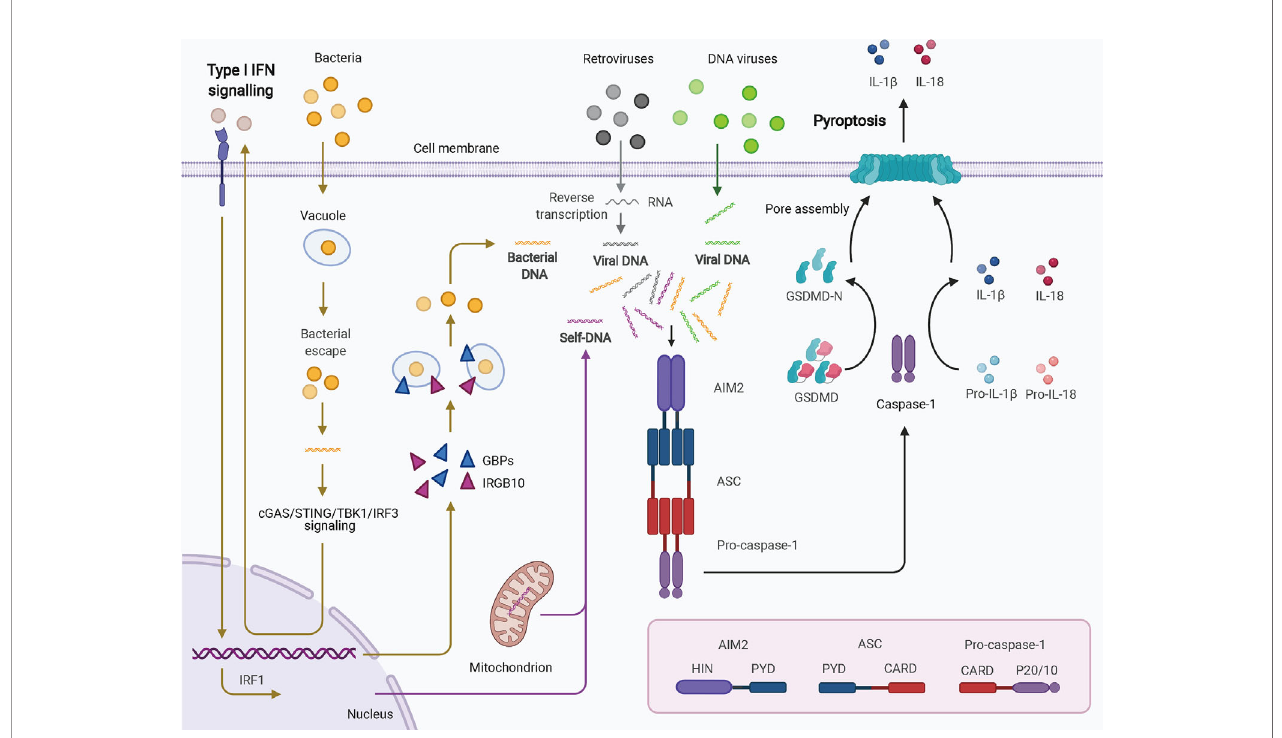
FIGURE 2 | Schematic of AIM2 in fl ammasome activation. Cytosolic DNA from virus and self-origin directly causes “ canonical ” activation of the AIM2 in fl ammasome (arrows in grey for retroviruses, green for DNA viruses, and purple for self-DNA). However, bacteria-induced “ noncanonical ” activation of the AIM2 in fl ammasome is dependent on type I IFN signaling (yellow arrows). In this scenario, small amounts of DNA may be released from intracellular bacteria that escape from vacuoles; this DNA can be detected by cGAS. Through cGAS/STING/TBK1/IRF3 signaling, type I IFN drives IRF1 expression in an autocrine manner. GBPs and IRGB10 are then produced and disrupt the bacterial membrane and vacuoles containing bacteria, leading to exposure of a mass of DNA. DNA is then recognized by the AIM2 in fl ammasome. AIM2 oligomerizes and interacts with pro-caspase-1 with the help of ASC. The activated caspase-1 processes pro-IL-1b and pro-IL-18 into mature IL-1b and IL-18 and cleaves GSDMD to induce pyroptosis. AIM2, absent in melanoma 2; ASC, apoptosis-associated speck-like protein containing a CARD; CARD, caspase activation and recruitment domain; cGAS, cyclic GMP-AMP synthase; GBPs, guanylate-binding proteins; GSDMD, gasdermin D; HIN,